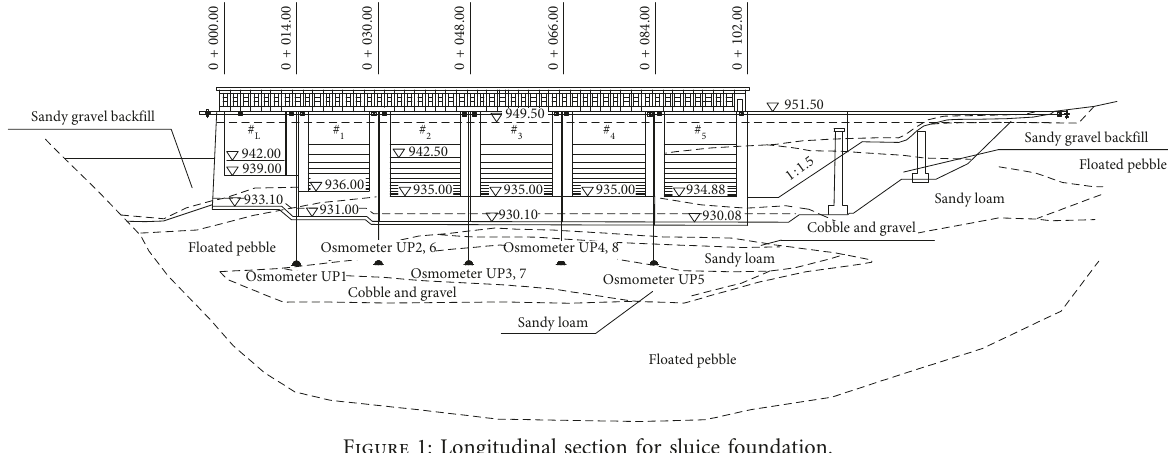
Figure 1: Longitudinal section for sluice foundation.